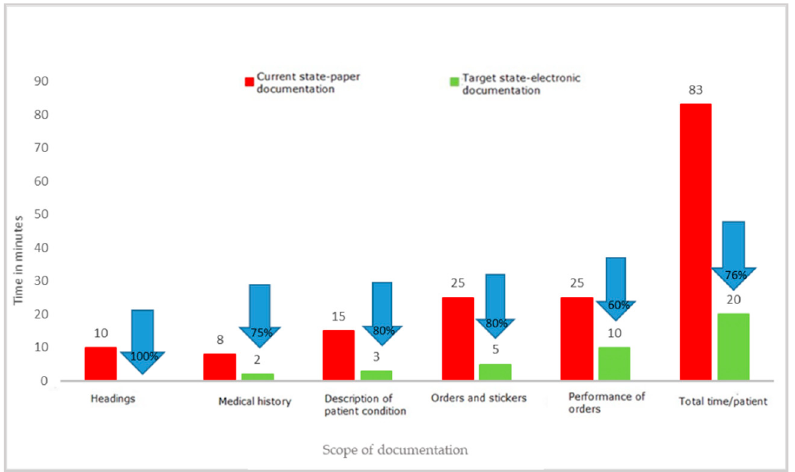
Figure 9. Time to complete the nursing documentation of a newly admitted patient. Source: Own study based on the hospital materials.